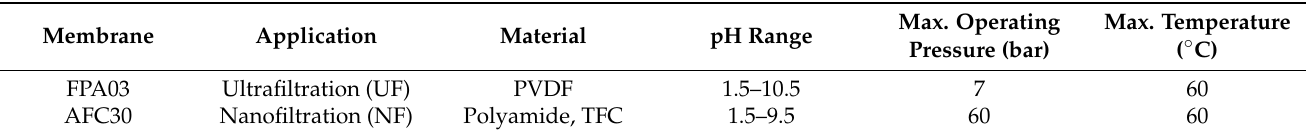
Table 2. Main characteristics of filtration